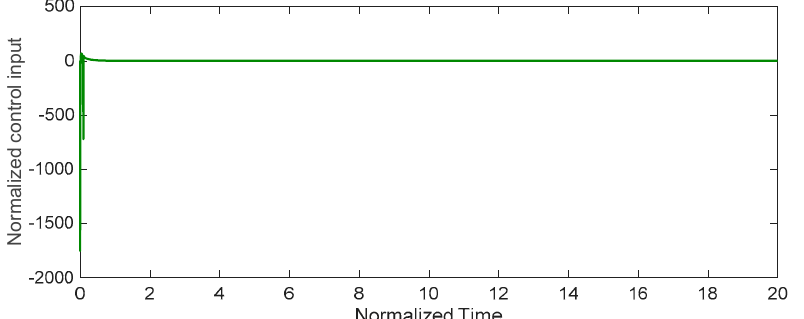
Figure 5. The control input of the closed-loop system based on the proposed control scheme.